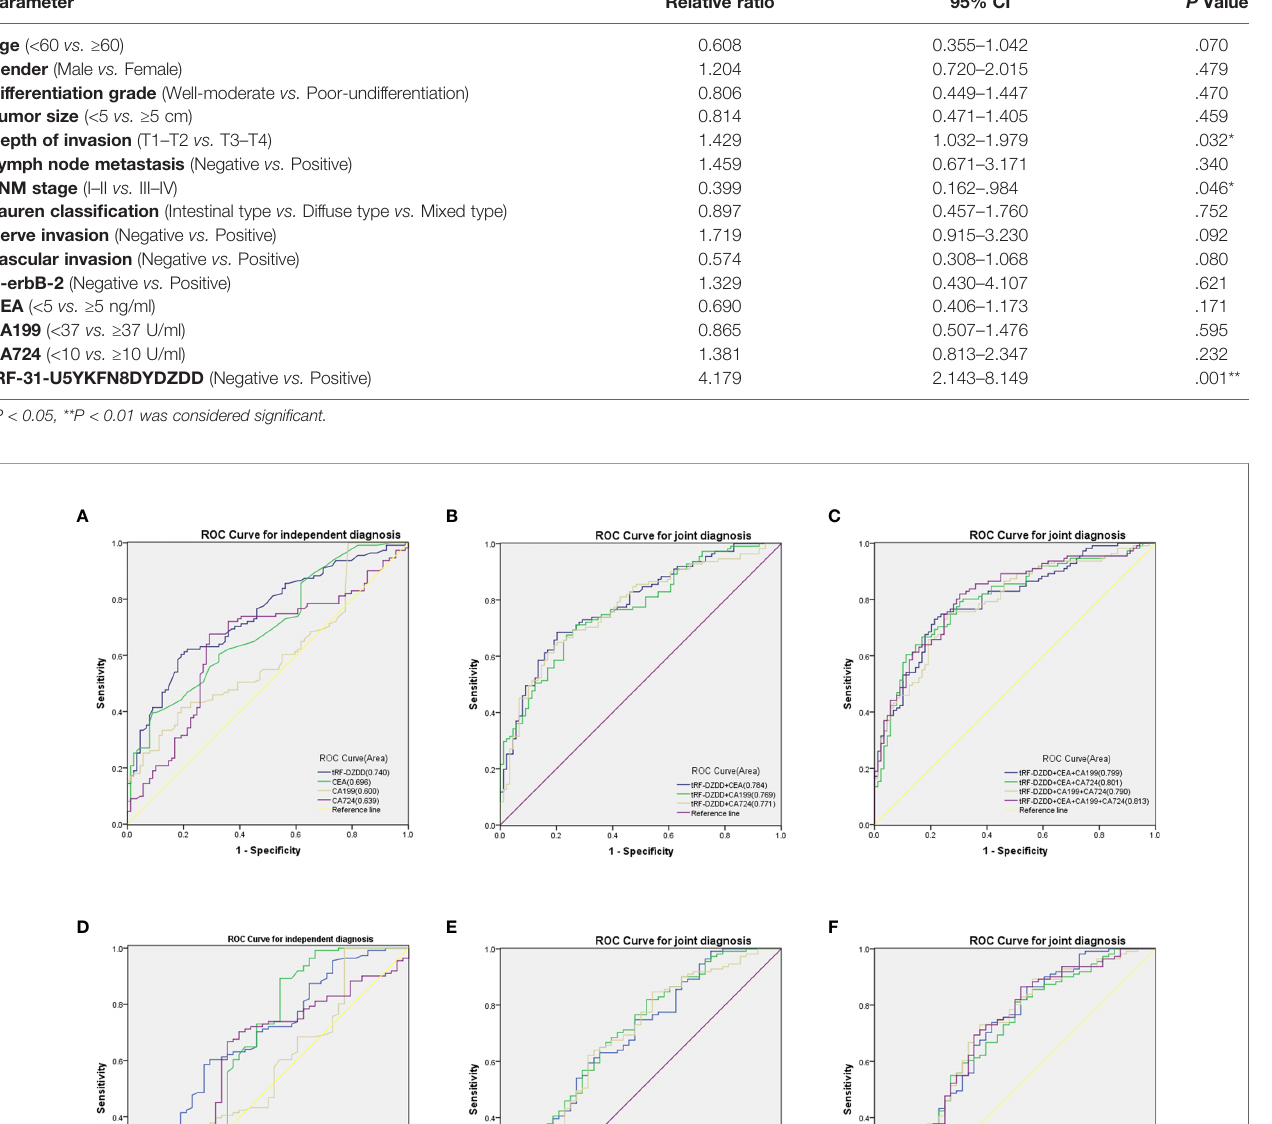
TABLE 3 | Multivariate Cox regression analysis of tRF-31-U5YKFN8DYDZDD and clinical variables predicting survival from 111 GC specimens. Parameter